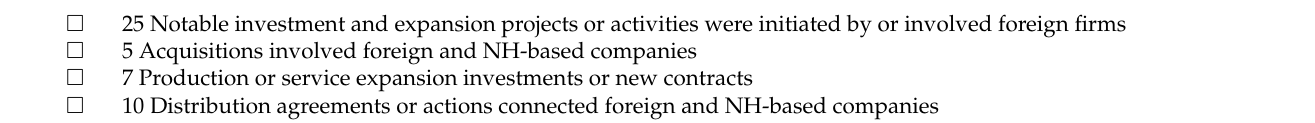
Table 3. Key foreign business activity during the COVID pandemic.